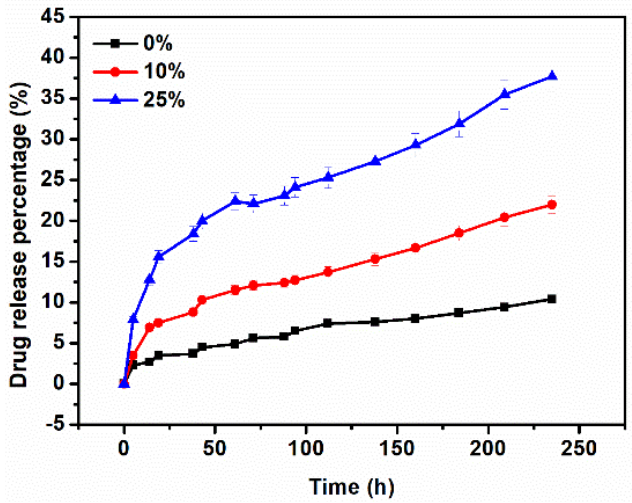
Figure 6. Release profiles of DOX − incorporated PCL/HA scaffolds with 0%, 10%, and 25% of HA content for 250 h.